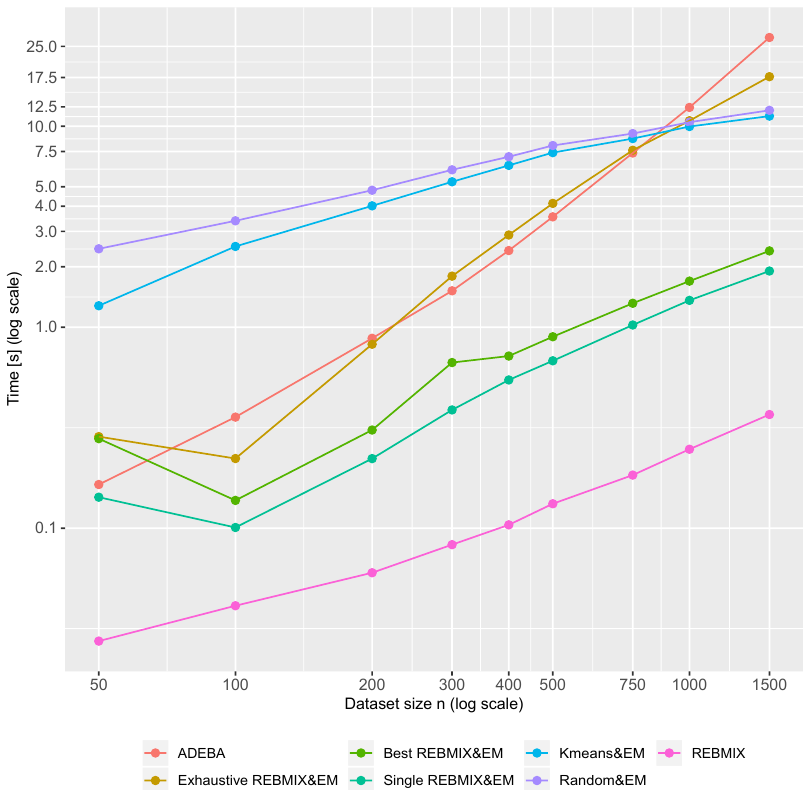
Figure 8. Mean computation times of Exhaustive REBMIX&EM strategy, Best REBMIX&EM strategy, Single REBMIX&EM strategy, Kmeans&EM, Random&EM, and ADEBA for each dataset size n